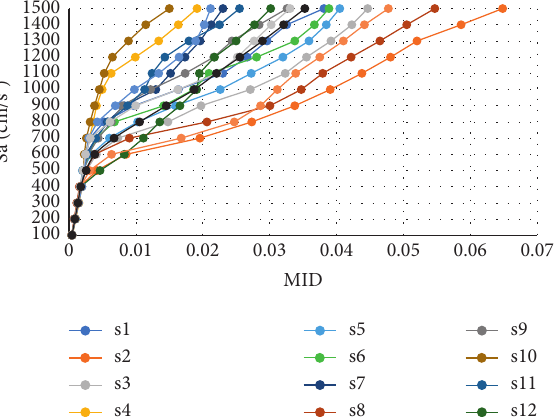
Figure 10: IDA curves for 12-story building.